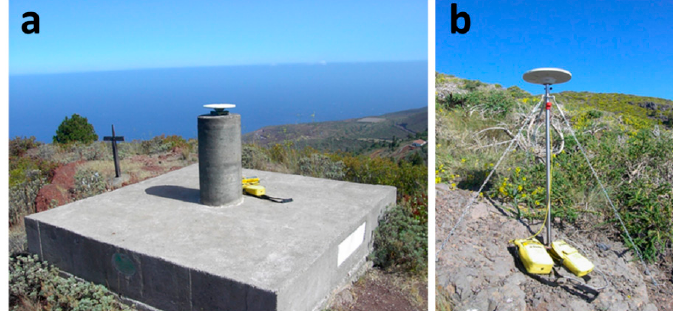
Figure 2. Examples of the two kinds of network geodetic markers: ( a ) a concrete pillar, equipped with a centering device, on a square concrete foundation anchored to the rock; and ( b ) a benchmark steel bolt anchored to the rock.